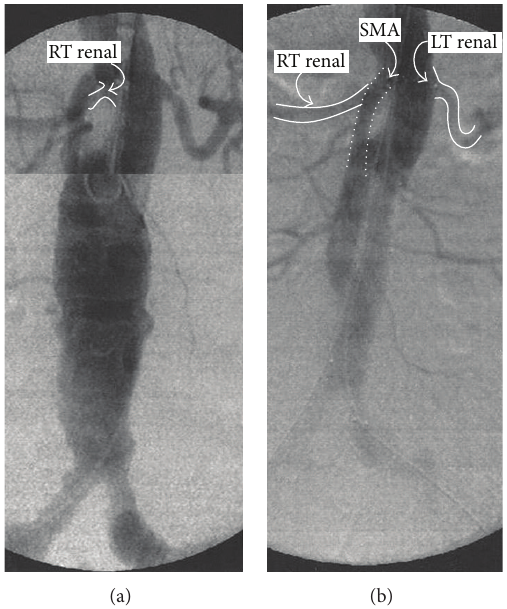
Figure 2: Predeployment preliminary angiography (a). Final con- trol (b) showed the patency of both the renal arteries